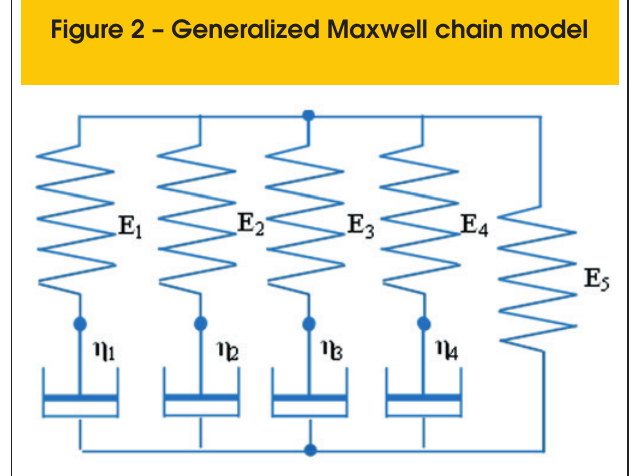
Figure 2 – Generalized Maxwell chain